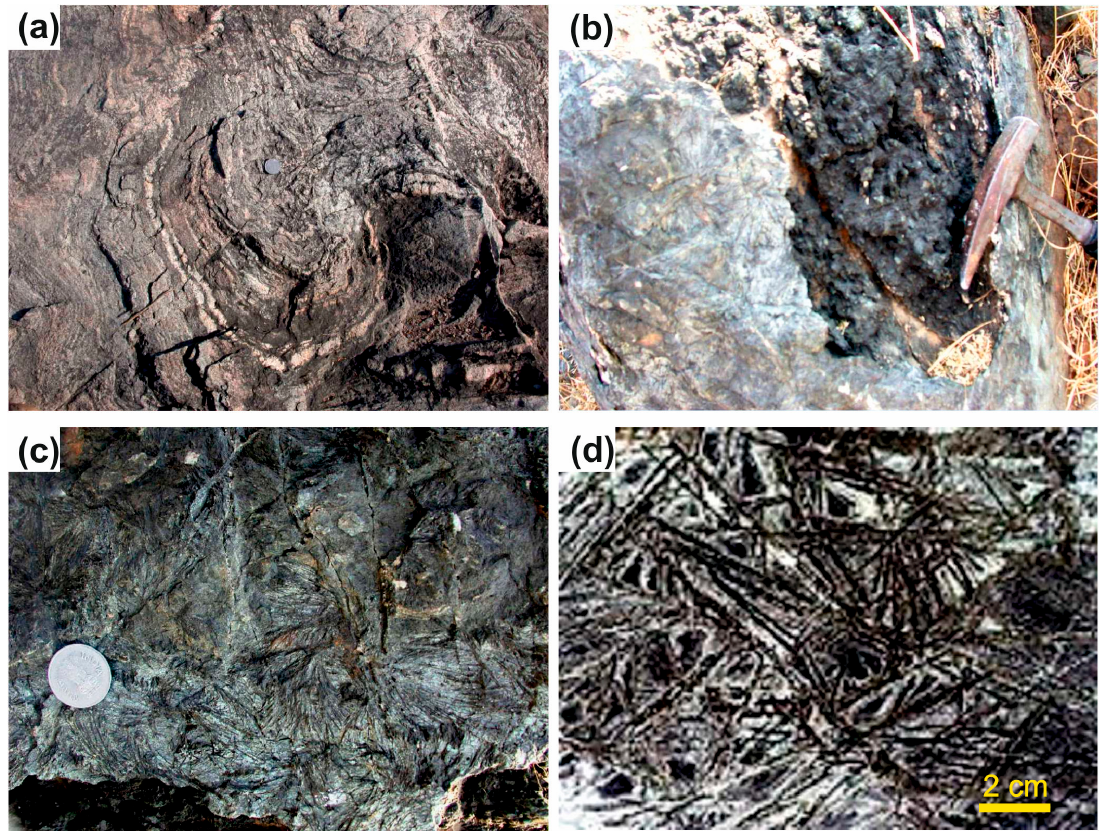
Figure 2. Field photographs showing morphology of the pillow lava outcrops at the Aravalli area. ( a ) pillow structures showing deformation, ( b ) oval shape of the pillow lava in the Aravalli area with visible spinifex-like texture on the surface, ( c , d ) fibrous and platy amphibole on the Aravalli pillow lava surface. Note the hammer and the coin for scale.